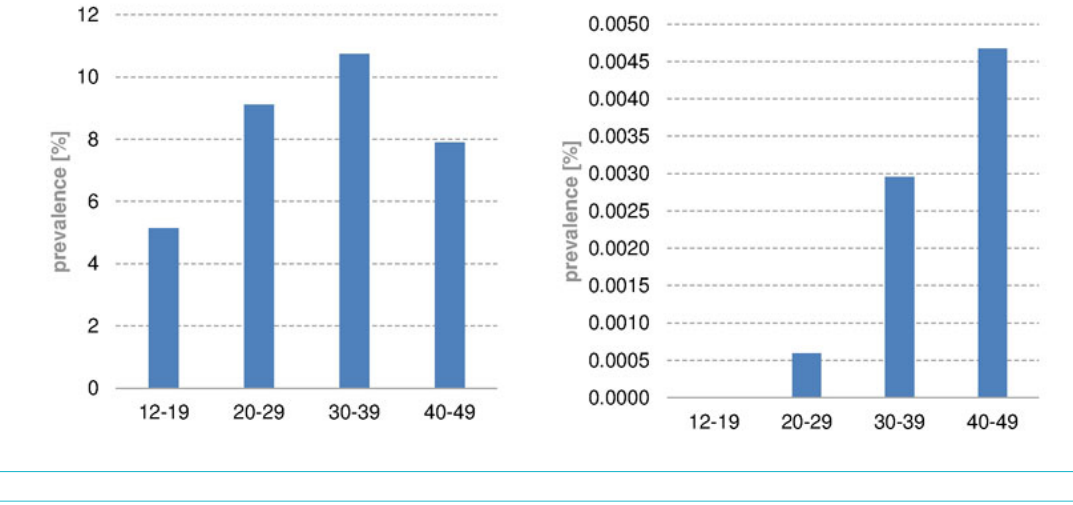
Figure S2: Prevalence of oral and parenteral iron substitution of women of childbearing age in Switzerland, 2012 to